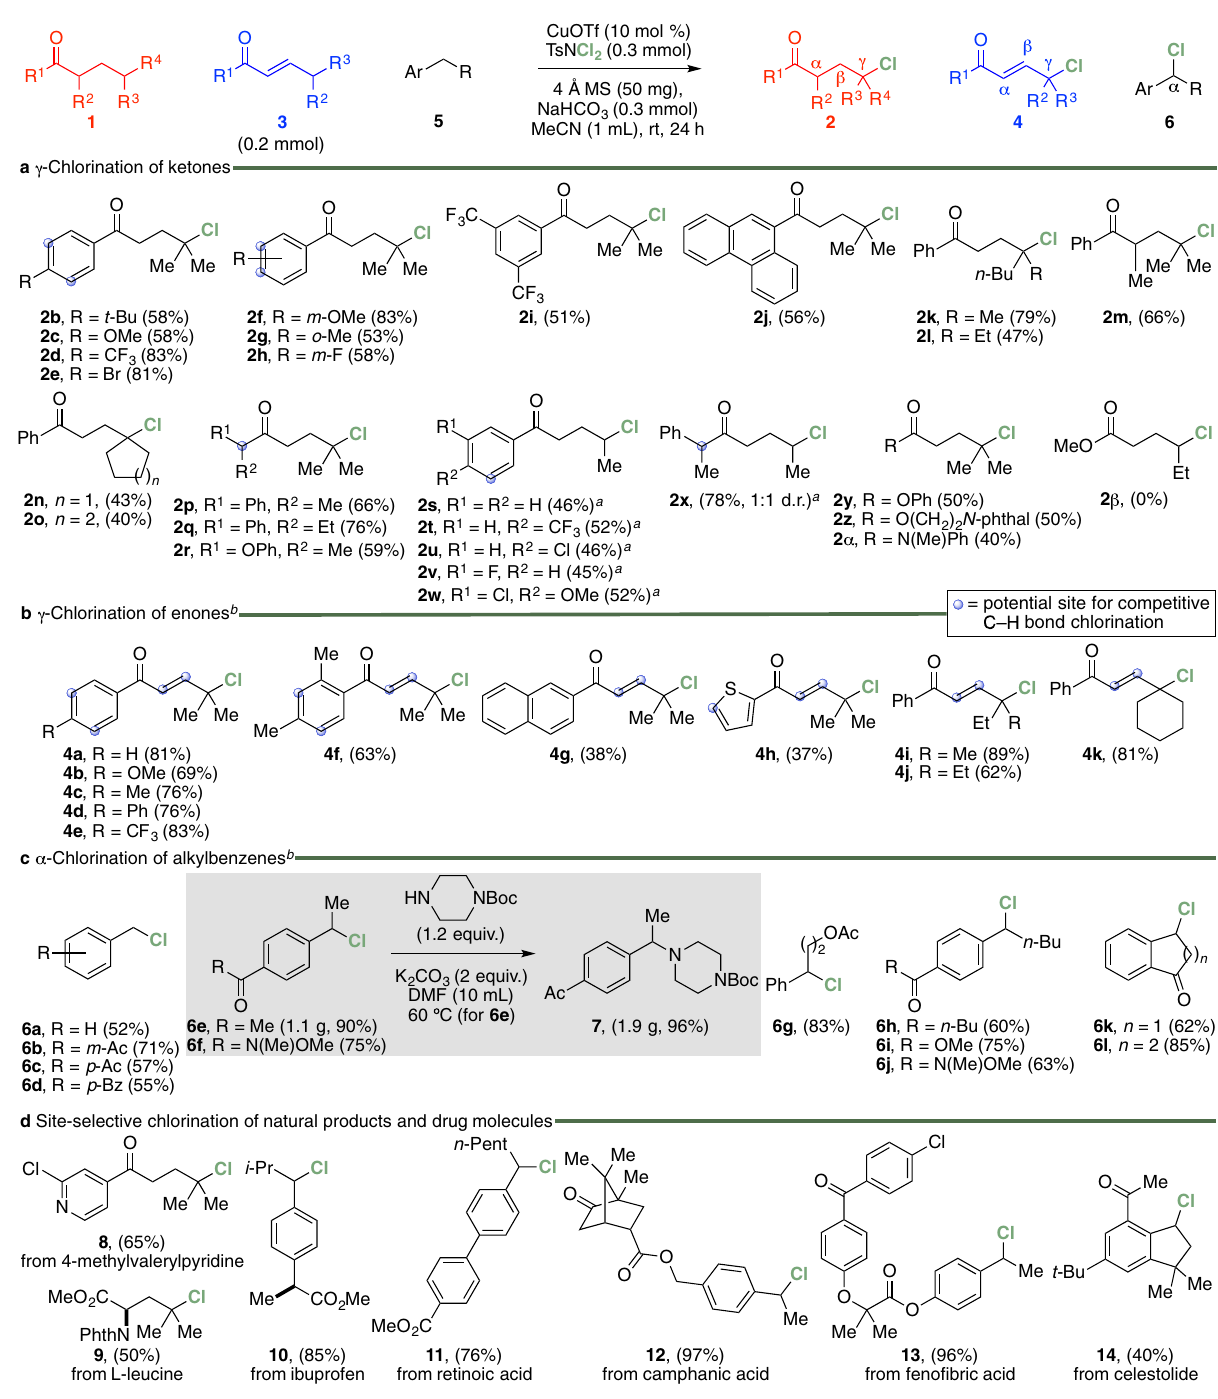
Fig. 2 Scope and synthetic applications of the CuOTf-catalysed site-selective C( sp 3 ) – H bond chlorination reaction. a At the γ -position of ketones. b At the γ -position of ( E )-enones. c At the α -position of alkylbenzenes. d Late-stage chlorination of natural products and drug molecules. a Reaction performed with 20 mol % of CuOTf and 0.6 mmol of dichloramine-T for 48 h. b Reaction performed with 0.24 mmol of